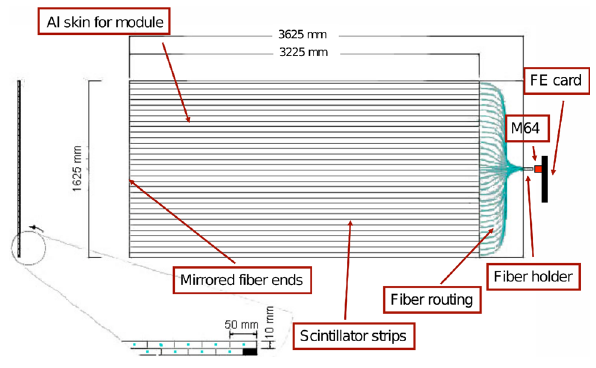
Fig. 6 Schematic drawing of a short OV module. The 32 strips in the top layer are visible in the diagram, with fibers (light blue) routed to the fiber holder, which is attached to an M64 multi-anode PMT and front end (FE) board. In the inset at the bottom of the figure the two layers of strips can be seen, offset by half a strip width. Each strip was 50mm wide and 10mm thick and had a single fiber in the center. The strips at the far end of the PMT were mirrored to provide better light collection at the PMT. The whole module was covered with an aluminum